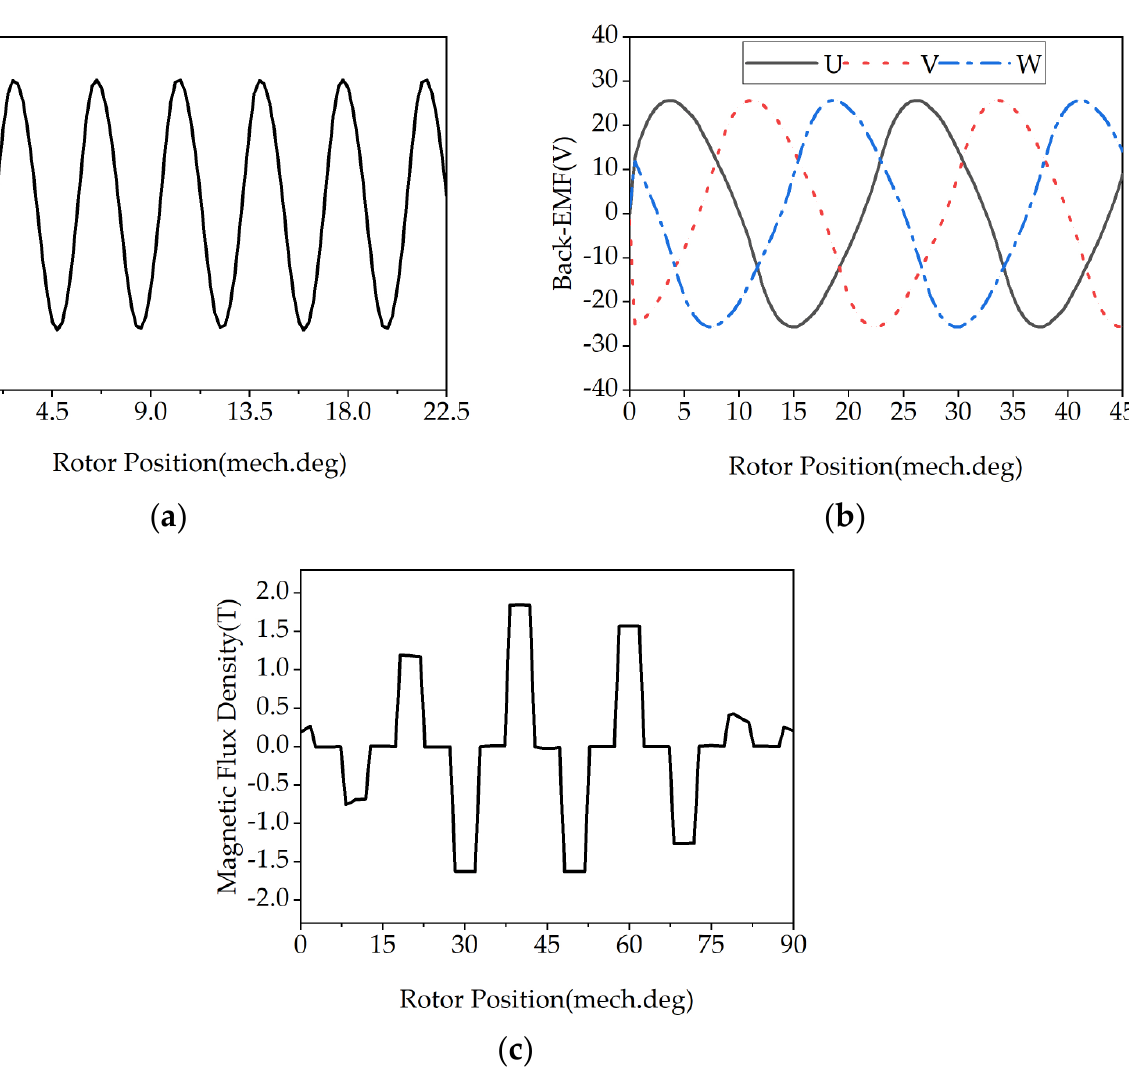
Figure 8. The simulation results under triple overload. ( a ) Output torque; ( b ) phase back-EMF; ( c ) tooth magnetic density.